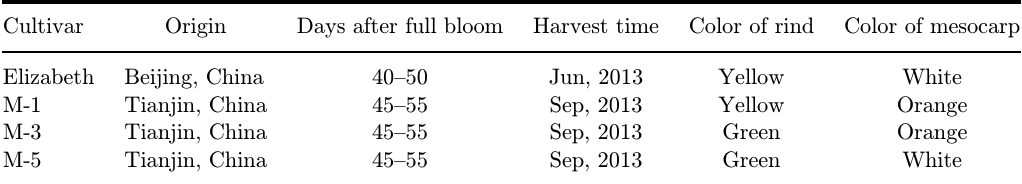
Table 1. Characteristic of four cultivars melon